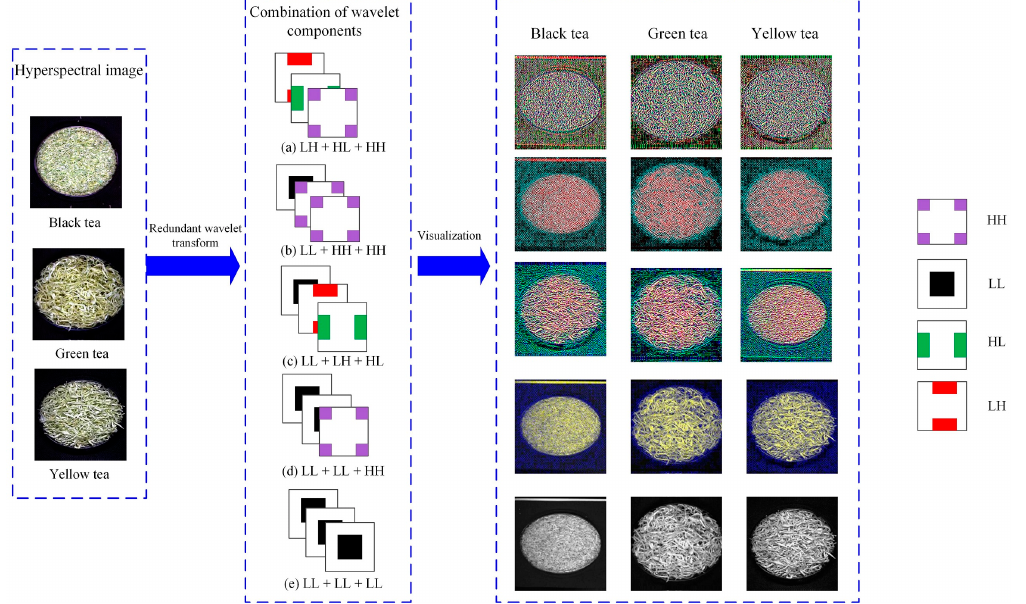
Figure 6. Combinations of different wavelet components.